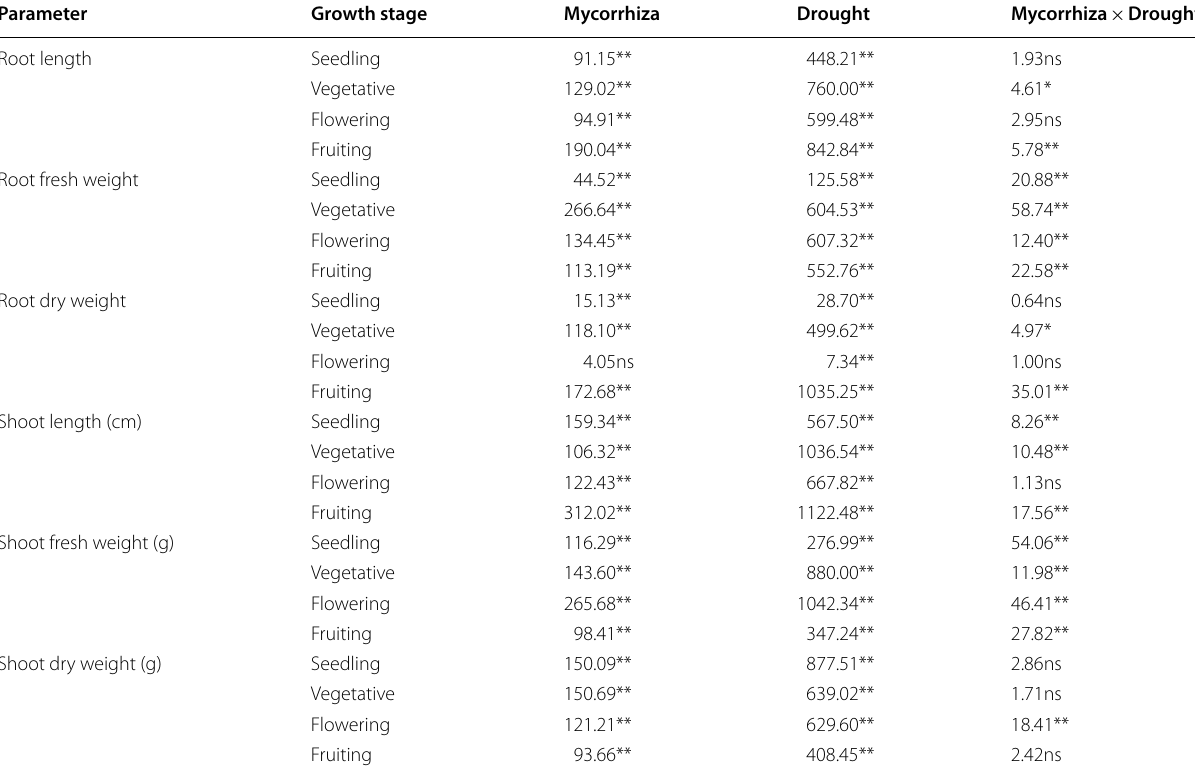
Table 3 Two‑ way ANOVA of Growth criteria of Ocimum basilicum under Drought and mycorrhiza; Error,